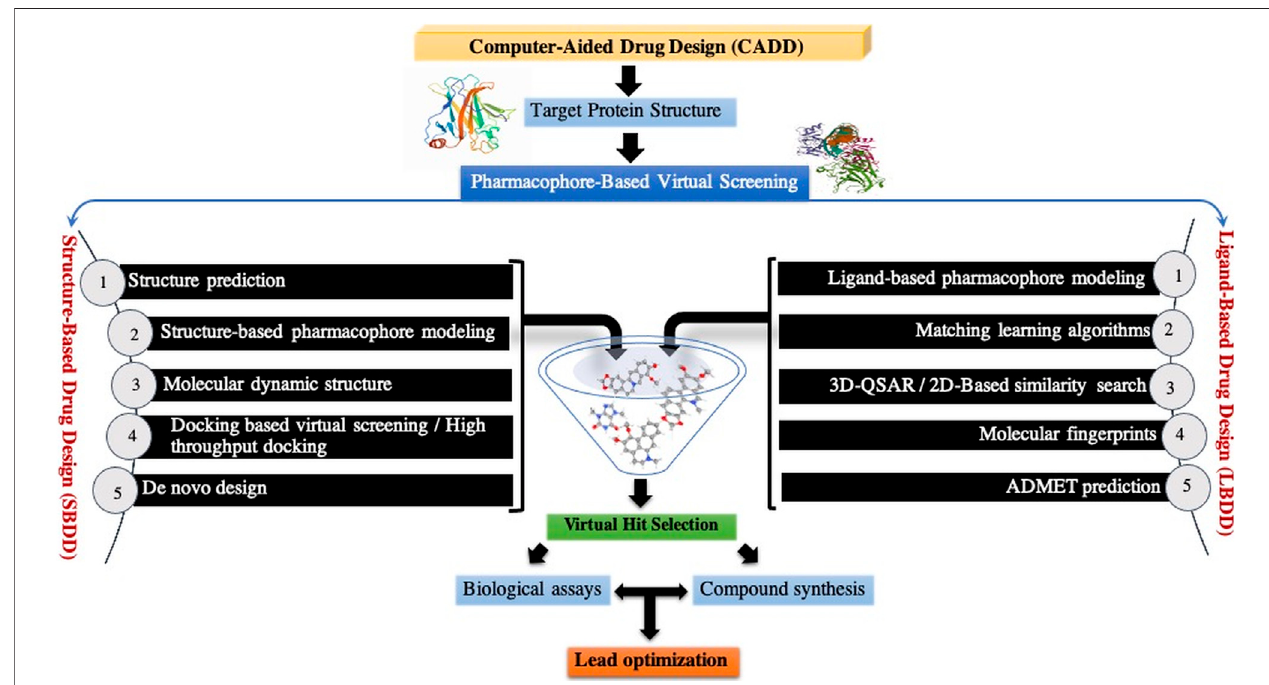
FIGURE 12 | Work fl ow of structure- and ligand-based virtual screening